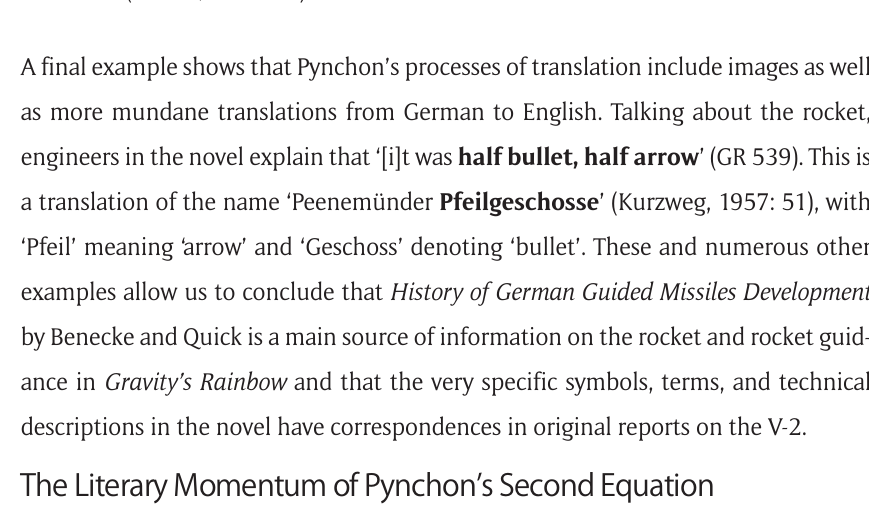
Figure 2: Scheme of the electronic device for integrating the velocity of the missile (Müller, 1957: